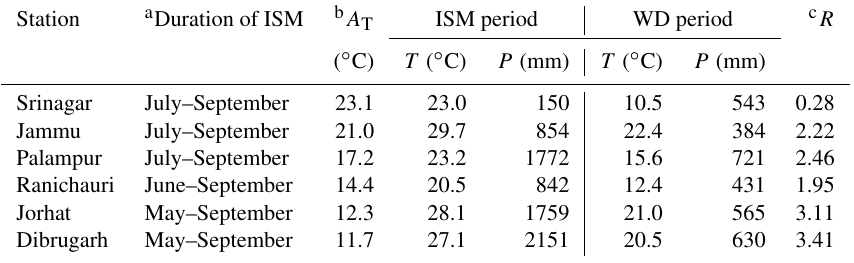
a Onset and duration of ISM period defined operationally on the basis of seasonal distribution of long-term monthly rainfall (cf. Fig. 2) and through examination of individual backward trajectories calculated for daily rainfall events The ratio of cumulative rainfall amount collected at the given station during ISM and WD periods.